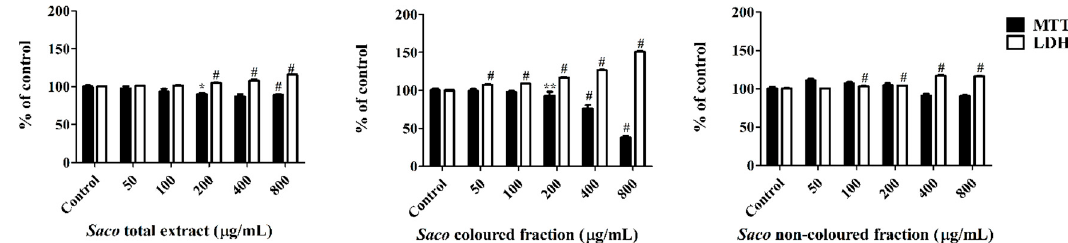
Figure 3. Effect of Saco extracts on Caco-2 cell lines viability after 24 h of exposure, assessed by 3-(4,5-dimethylthiazol-2-yl)-2,5-diphenyltetrazolium bromide (MTT) reduction and lactate dehydrogenase (LDH) leakage assays. Values show mean ± SEM of six independent assays performed in triplicate (* p < 0.05, ** p < 0.01 and # p < 0.0001).